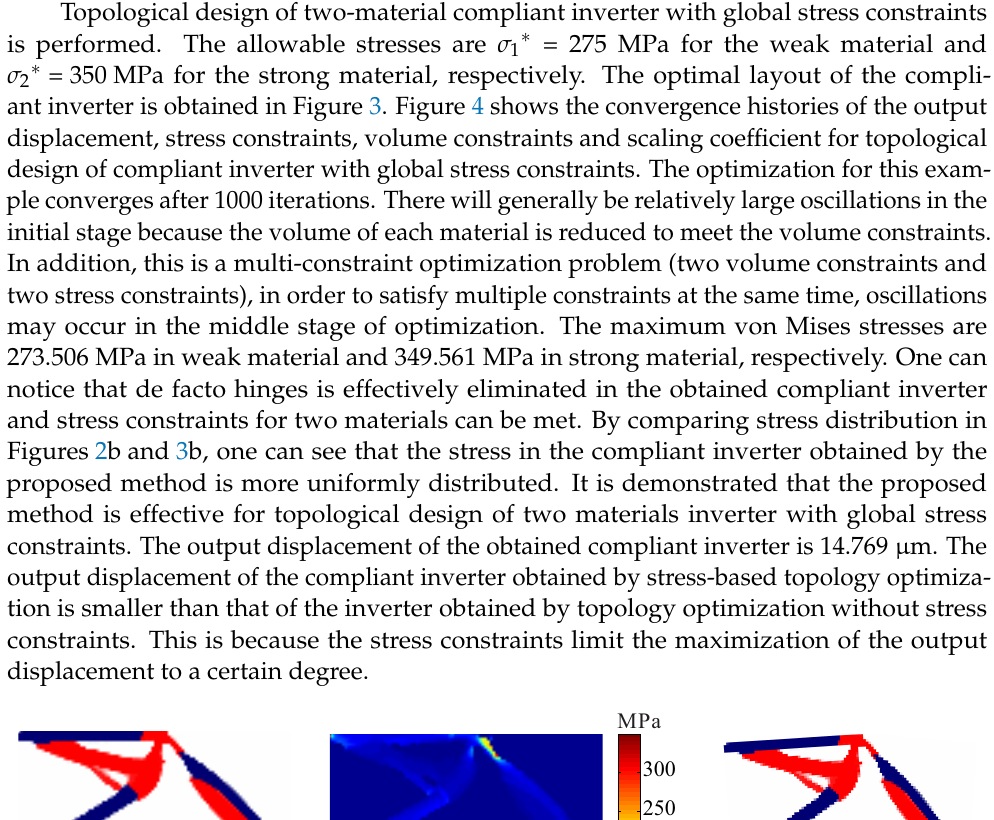
Figure 2. The results for topological design of multi-material compliant inverter without stress constraints. ( a ) Optimal topology; ( b ) stress distribution; ( c ) deformed configuration.